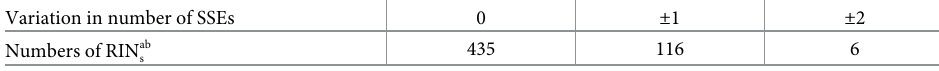
Table 2. RIN ab and variation on SSEs span. For each RIN ab we compute how the number of SSEs covered varies s between the occurrences. A value of 0 means that all occurrences are over the same number of SSEs while ± 1 (resp. ± 2) means that the RIN ab can span two different number of SSEs (resp.